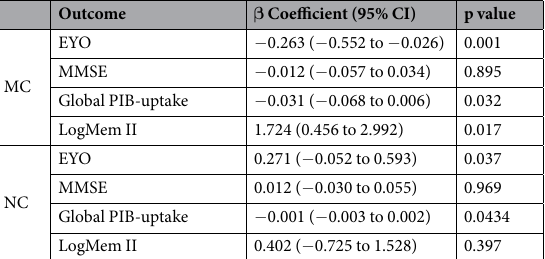
β Coefficient (95% CI)